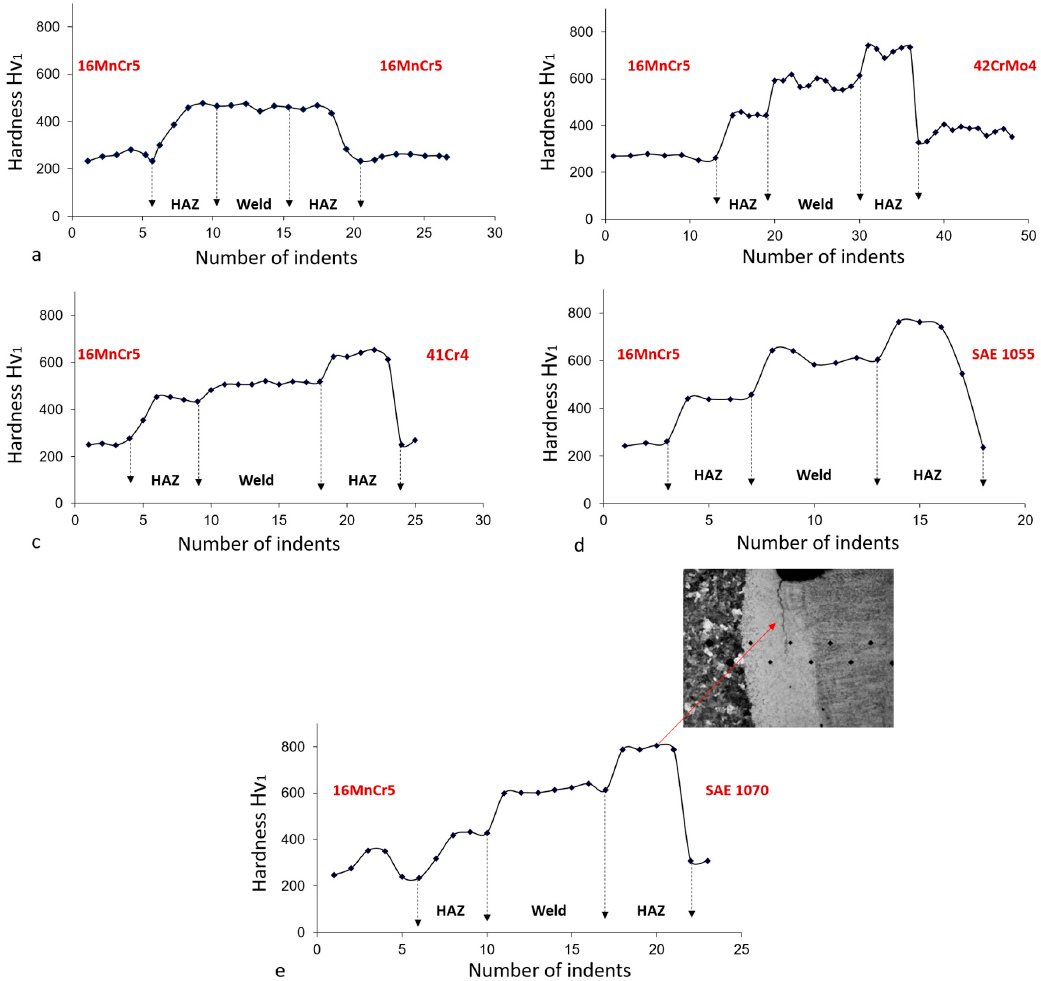
Figure 7. Hardness profiles for the following material combinations: ( a ) 16MnCr5-16MnCr5, ( b ) 16MnCr5-42CrMo4, ( c ) 16MnCr5-41Cr4, ( d ) 16MnCr5-SAE1055 and ( e ) 16MnCr5-SAE1070 with a micrograph showing the occurrence of cracking in the SAE1070